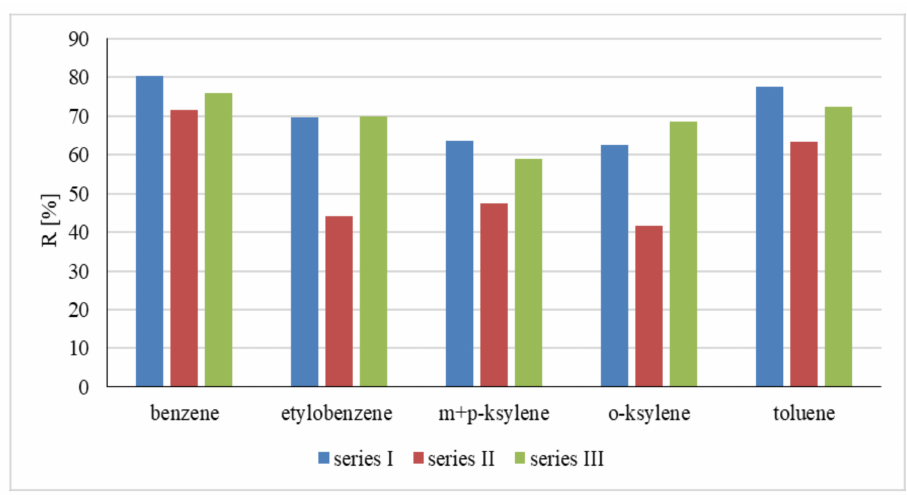
Figure 1. Change of the BTEX retention index in the individual lots at 1.2 MPa pressure.